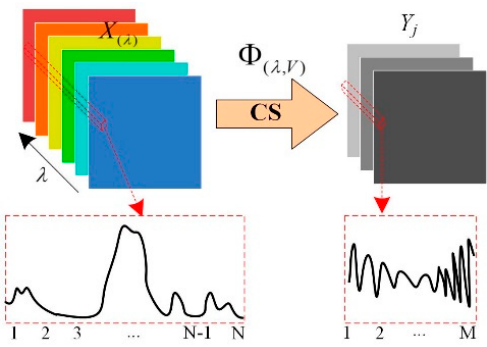
Figure 2. Spectrum compressed sensing process.